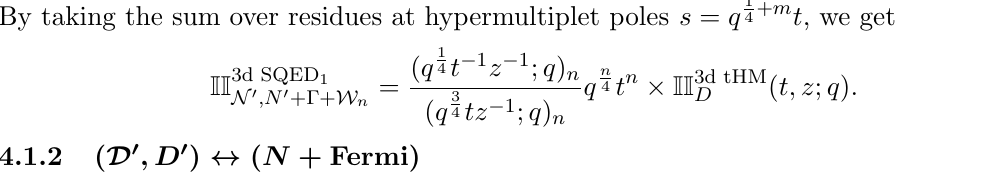
Figure 7 . The brane constructions of the Dirichlet b.c. ( b.c. N for twisted hypermultiplet with a boundary Fermi